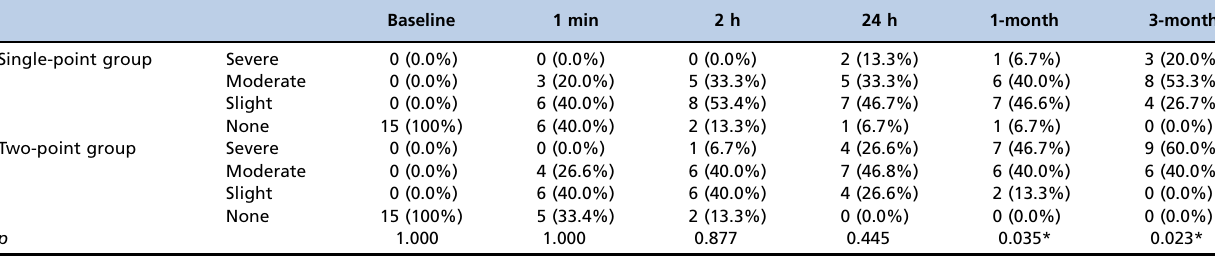
Table 3 - The degrees of numbness (number (percentage)).